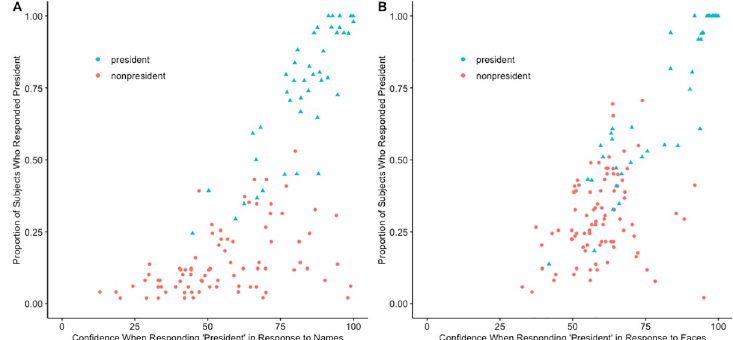
Fig 4. Scatterplots showing the association between the proportion of subjects who identified each individual as a president and the mean confidence rating for that choice. Each data point represents an individual, with triangles representing presidents and circles representing nonpresidents. Panel A represents names and Panel B represents faces. Note that six nonpresidents in Panel A and one nonpresident in Panel B are omitted because no subject false alarmed to those